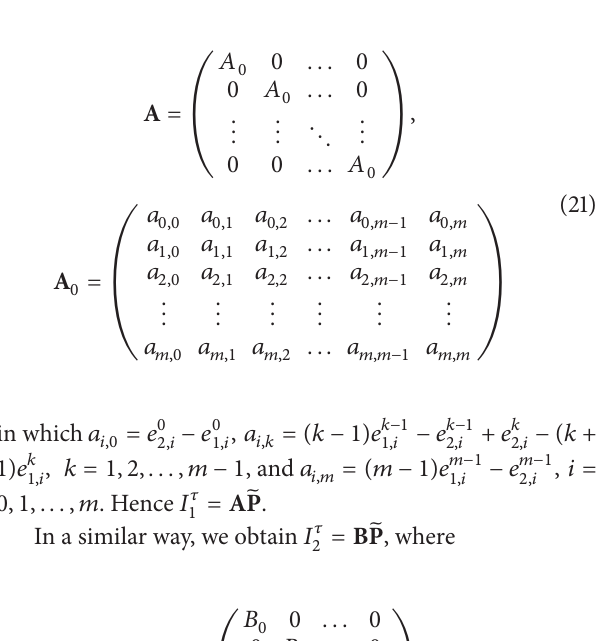
Table 1: Thebasic parameter values used in numerical